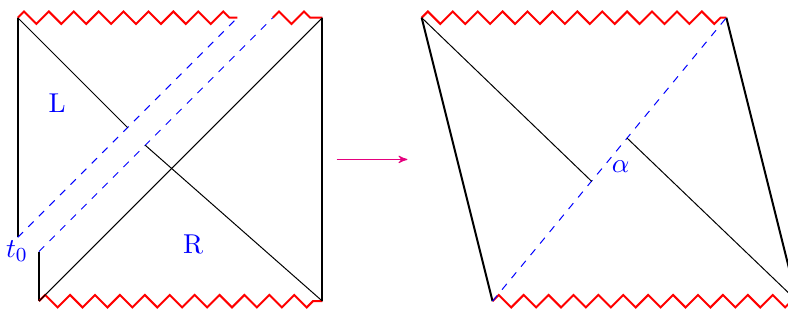
Figure 29 . The shock-wave geometry corresponds to the gluing of two-half spacetimes along the lightlike perturbation trajectory in the limit t 0 ! 1 , (cid:14)M ! 0 keeping (cid:11) / e (cid:20)t 0 (cid:14)M (cid:12)xed, giving rise to a shift V L = V R + (cid:11) in the Kruskal coordinate by (cid:11) . indicated in the left diagram in (cid:12)gure 29. As (cid:12)rst shown in [59], the non-trivial e(cid:11)ect of